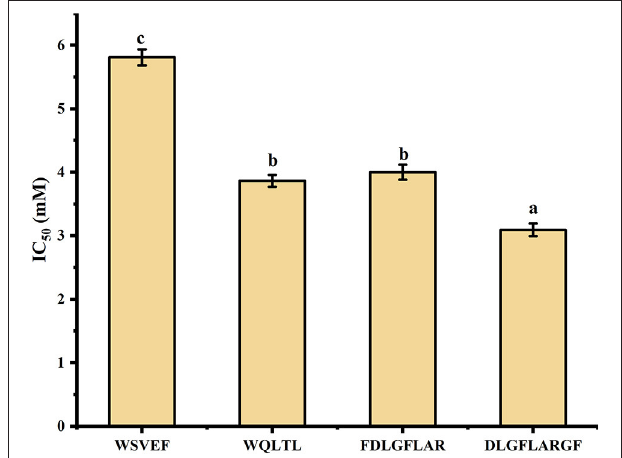
FIGURE 4 | Tyrosinase inhibitory activity of synthetic peptides. Different lowercase letters represent significant differences between different groups ( p <